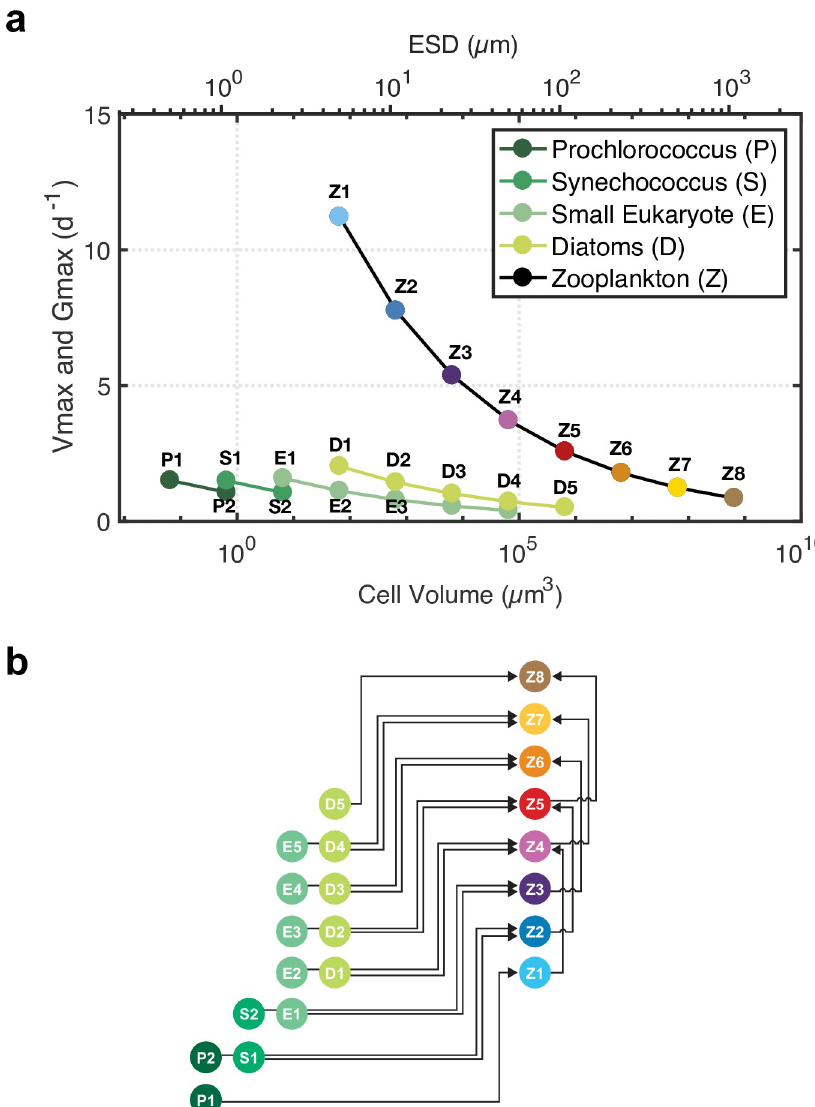
Fig 1. (a) Maximum phytoplankton growth rates and maximum zooplankton grazing rates as a function of cell size (volume and equivalent spherical diameter, ESD) and taxon. (b) Schematic representation of the ecosystem model simplified to show only grazing and predation fluxes for clarity (for a complete representation of the model, see Fig 2 in Ward et al. (2012) [24]). Phytoplankton functional types ( Prochlorococcus (P), Synechococcus (S), small Eukaryotes (E), Diatoms (D)) are divided into different size classes (P1, P2, S1, S2, etc.). Phytoplankton and zooplankton size classes (Z1, Z2, Z3, etc.) are represented with a color pallet used in subsequent